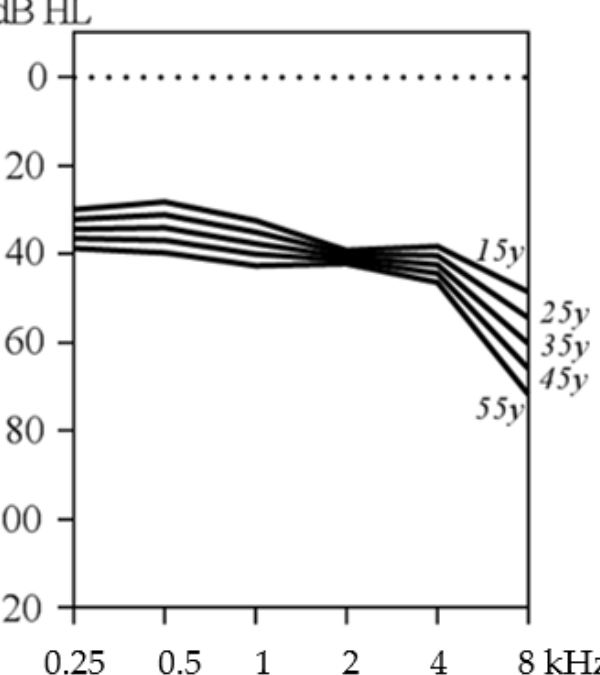
Figure 3. Age-related typical audiogram of patients with type 2 and type 3 Stickler syndrome. The audiogram was created via regression analysis including audiograms from four studies [17,25,26,28] using GraphPad Prism 9 (GraphPad Software Inc., La Jolla, CA, USA).